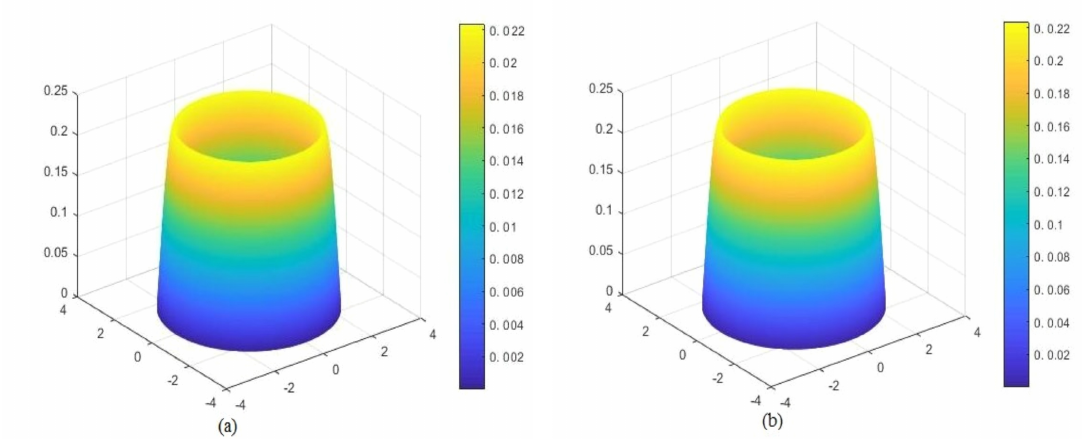
Figure 8. ( a ) The NBE solution u k at t = 0.2. ( b ) The analytical solution u k